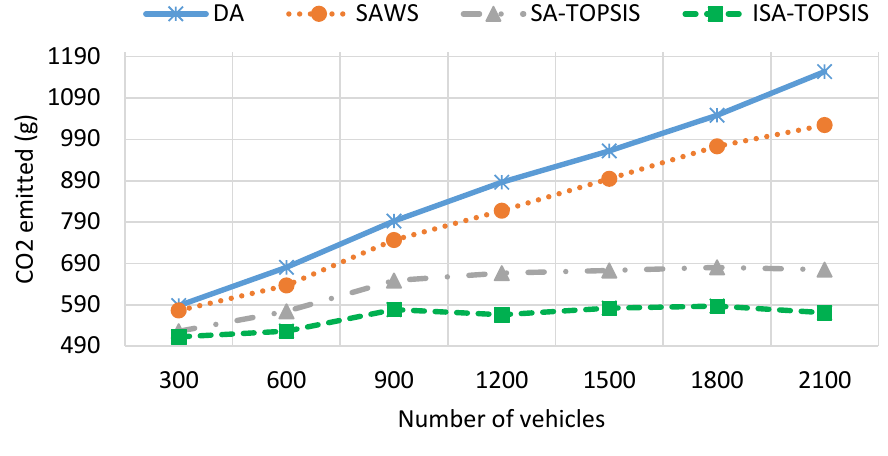
Figure 10. Average CO 2 emission.